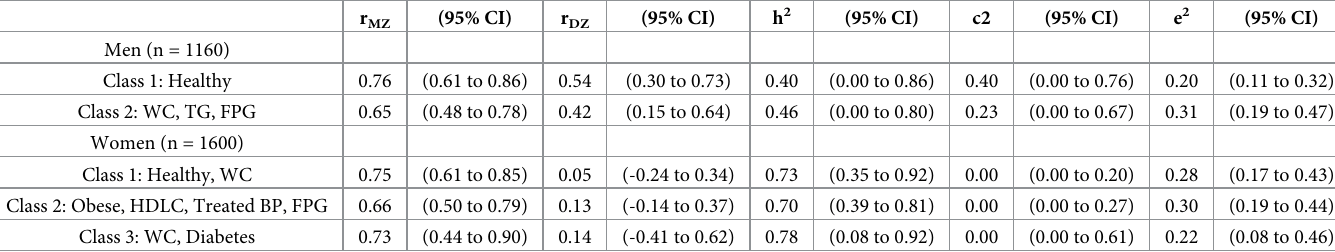
Table 4. Twin correlations and ACE decomposition of class membership for males and